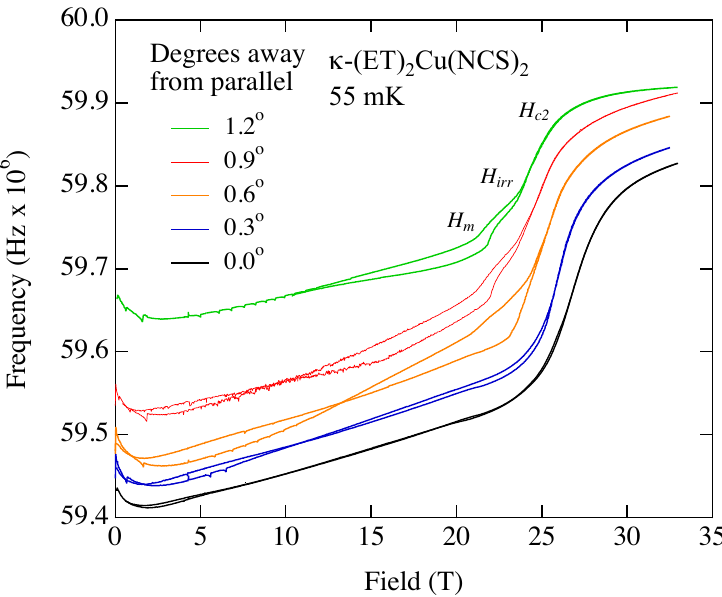
Figure 3. The angle dependence of the penetration depth near the parallel orientation for κ ET-CuNCS. The lowest trace is exactly parallel, or 90 ◦ in our absolute coordinates. The other traces are in order of increasing angle. The traces are vertically shifted to aid visualization. It is truly remarkable how all the vortex details are absent at the exactly parallel